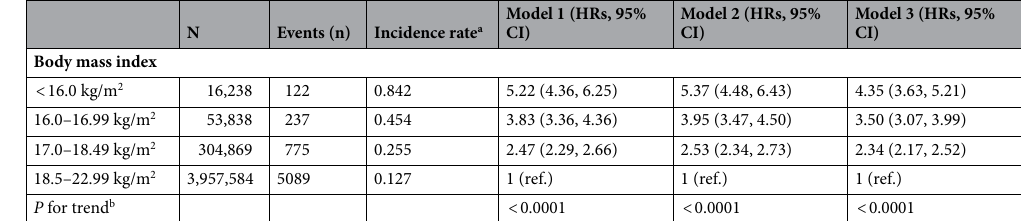
Table 2. Risk of non-tuberculosis mycobacterial pulmonary disease according to the severity of underweight. Model 1, adjusted for age and sex; Model 2, model 1 + smoking, alcohol intake, and regular exercise; Model 3, model 2 + respiratory diseases, solid cancer, hematologic malignancy, transplantation, AIDS, GERD, connective tissue diseases, diabetes mellitus. a Per 1000 person-years. HRs hazards ratios, 95% CI 95% confidence interval. b P -values for the trend were < 0.0001 for all variables because of the large size of the study population.